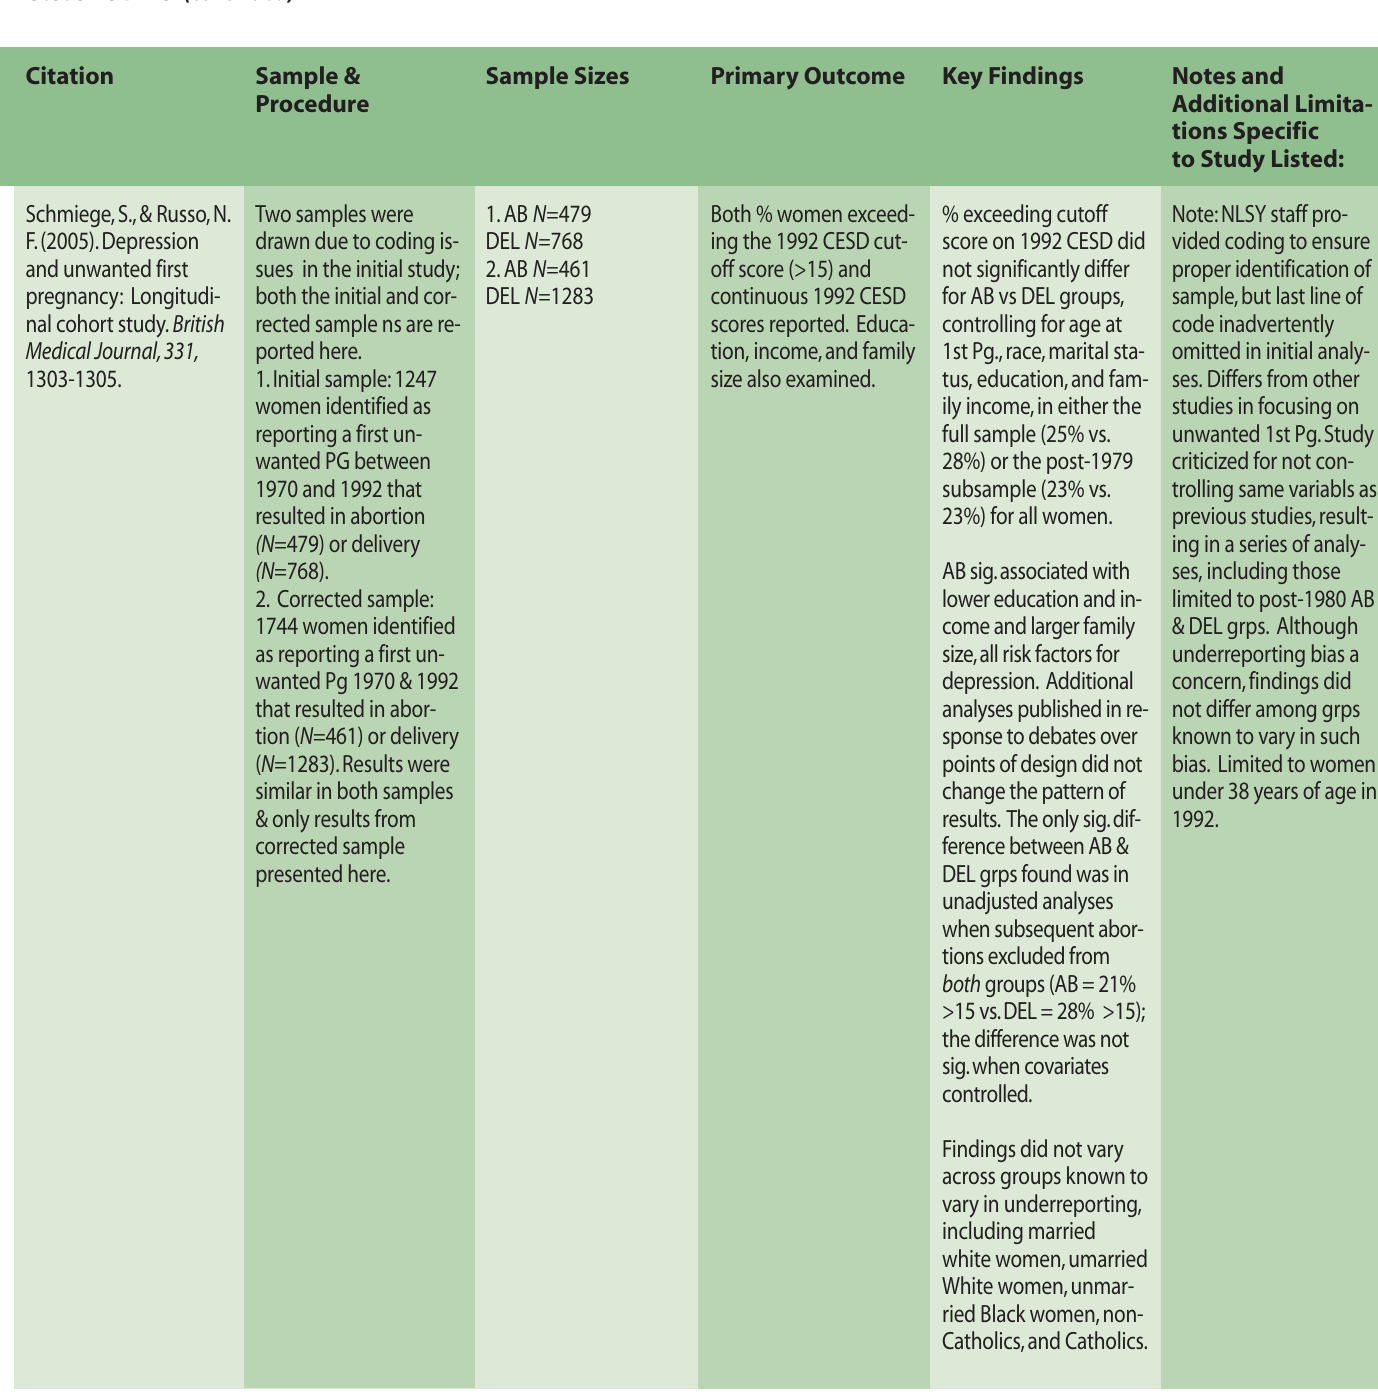
Table 1B: Secondary Analyses of Survey Data–Abortion vs.Comparison